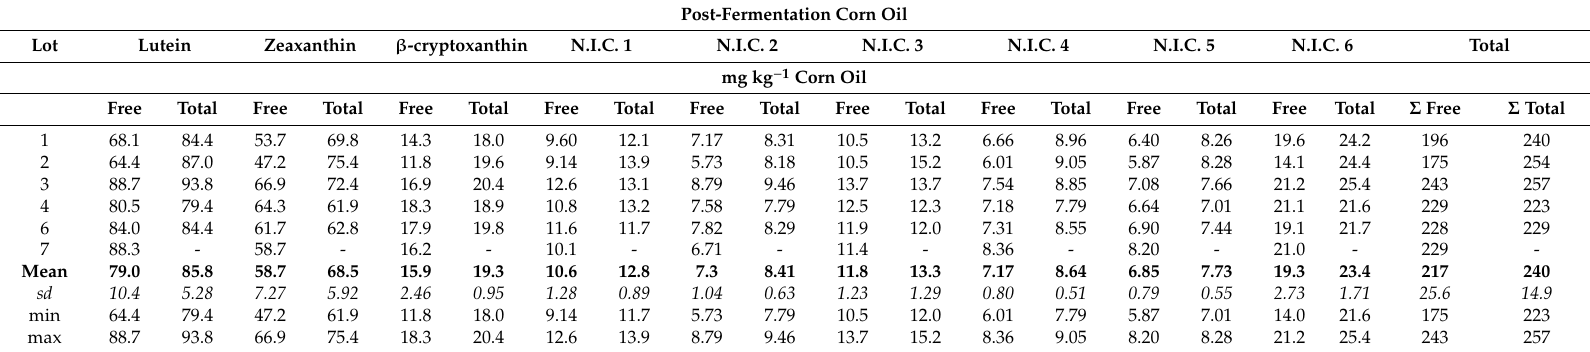
Table 5. Free and total amounts of carotenoids in post-fermentation corn oil from a dry-grind corn ethanol plant. Data refer to individual lots collected at monthly intervals from July 2018 to April 2019 and overall mean, standard deviation ( sd ), and range of values observed ( n = 6) *. Post-Fermentation Corn